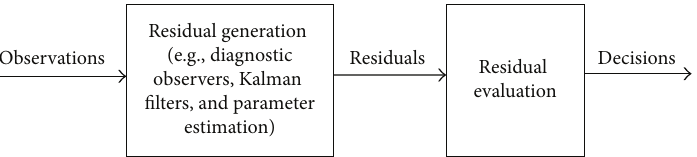
Figure 2: The two main stages in model-based fault detection and diagnosis (redrawn from